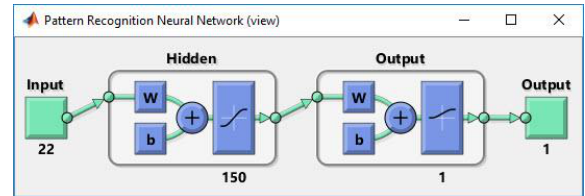
Figure 3 Structure of FFNN predictor for